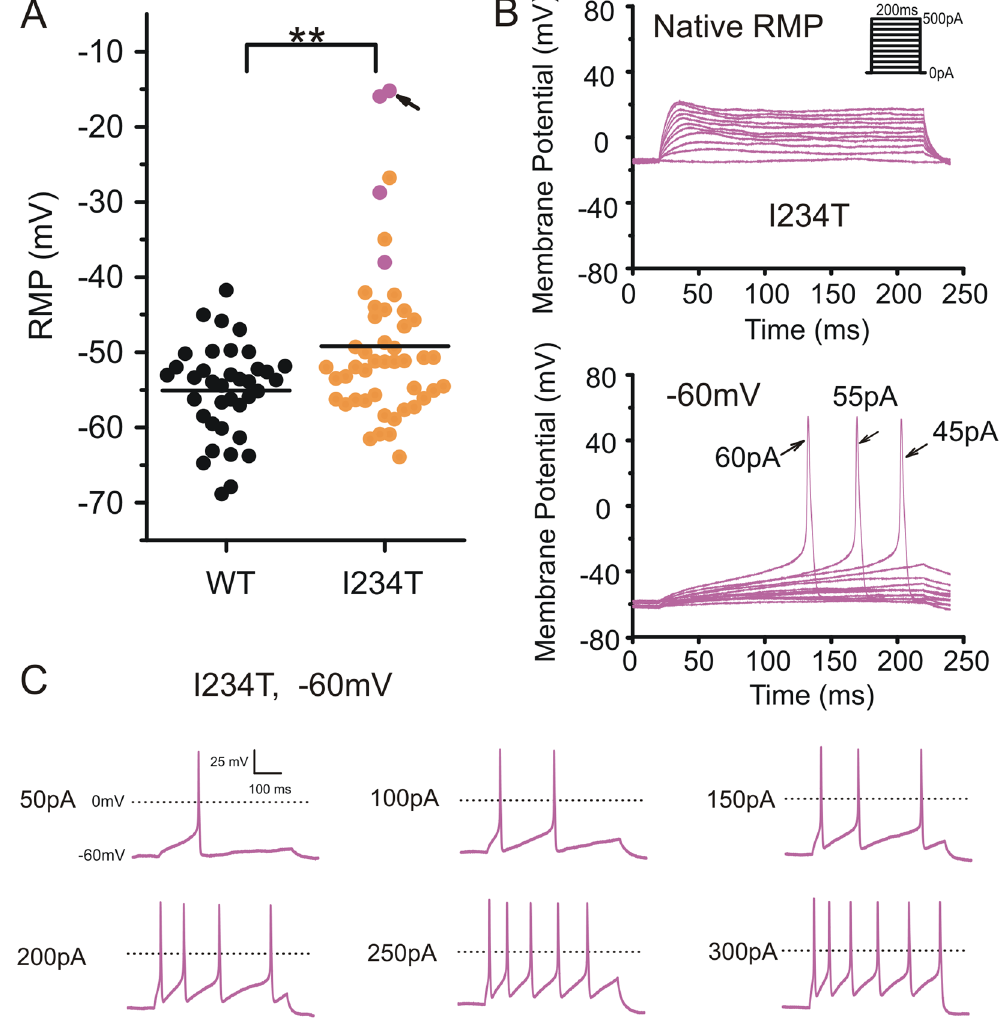
Figure 1. Expression of I234T leads to massive depolarization of RMP and inexcitability in a small number of DRG neurons. ( A ) Scatter-plot of native resting potentials in neurons expressing either WT or I234T hNa v 1.7 channels. Filled circles in magenta indicate cells that do not fire any all-or-none action potentials in response to external stimuli at their native resting potentials but regain excitability when held at − 60 mV. ** Indicates statistical significance ( p < 0.01). ( B ) A small DRG neuron with a native resting potential of − 15.2 mV (arrow in A ) does not produce action potentials in response to 200 ms current injections from 0 to 500 pA in 50 pA increments (upper). When held at − 60 mV, this cell generates action potentials when stimuli exceed 45 pA (lower). Arrows with numbers indicate stimuli used to elicit the labeled response. ( C ) The same neuron in ( B ) which does not fire action potentials at its native resting potential of − 15.2 mV, when clamped at − 60 mV, fires repetitively in response to 500 ms current injections that are multifold of its current threshold (i.e. 45 pA). Numbers to the left of action potential traces indicate the